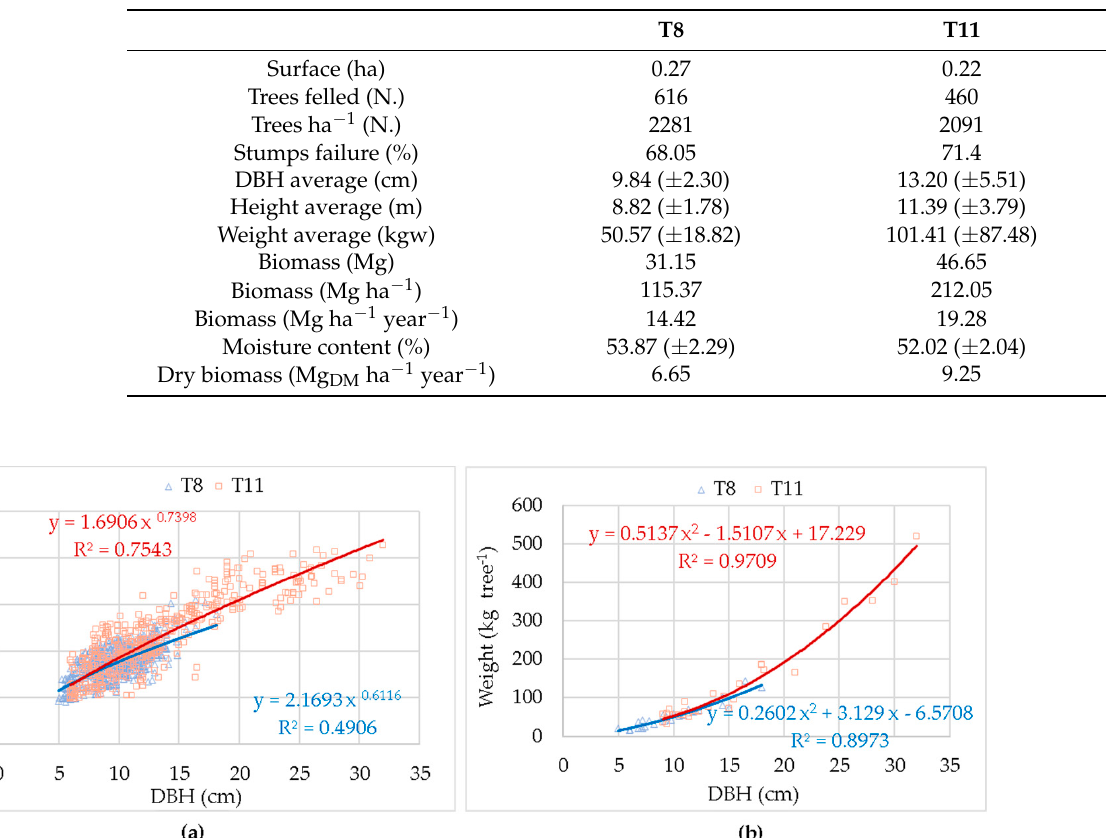
Figure 3. Relationship between height and diameter at breast height (DBH) in T8 (616 obs.) and T11 (460 obs.) plantations ( a ), and weight equations as a function of the DBH (30 obs. for each section) ( b ).